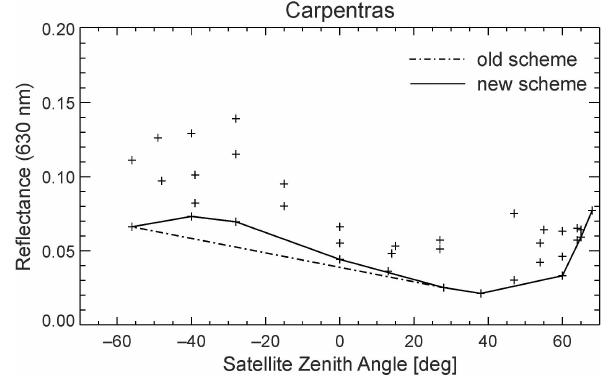
Fig. 1. Example for the estimation of ρ SFC by searching the min- imum reflectance within a certain period at the AERONET site of Carpentras. Crosses indicate cloud and cloud shadow free re- flectance observations under varying satellite zenith angle during a 45-days period in Summer 2005. The doted line indicates the old convex hull scheme of Hauser et al. (2005a), the solid line is the re- sult of the new scheme for the landuse type cropland (cf. Sect. 3.2). Positive satellite zenith angles refer to forward